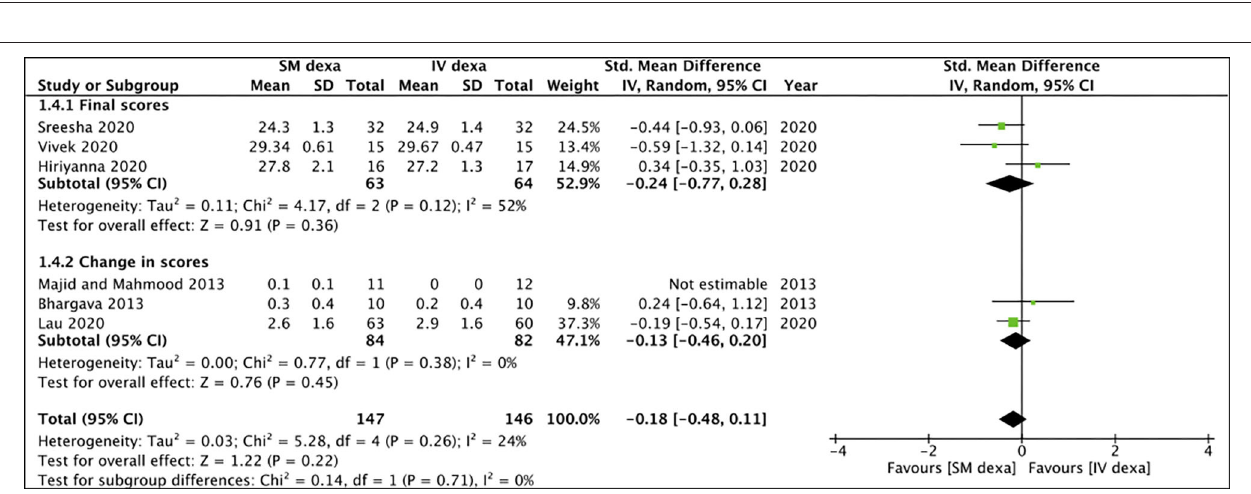
FIGURE 4 | Meta-analysis of early swelling between SM and IV dexamethasone (dexa) for third molar surgeries. Sub-group analysis performed based on final scores or change scores.